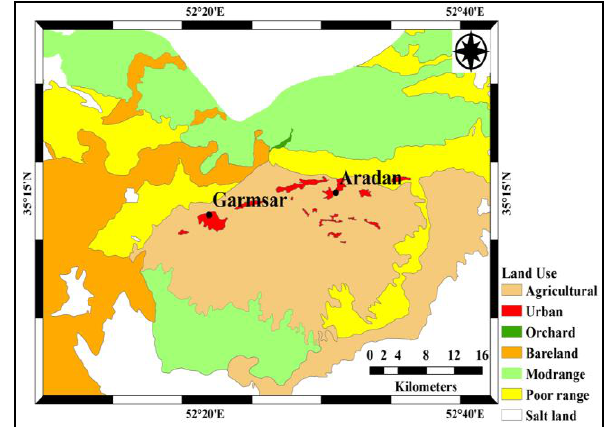
Figure 1. Location of the study area in Iran, based on land use